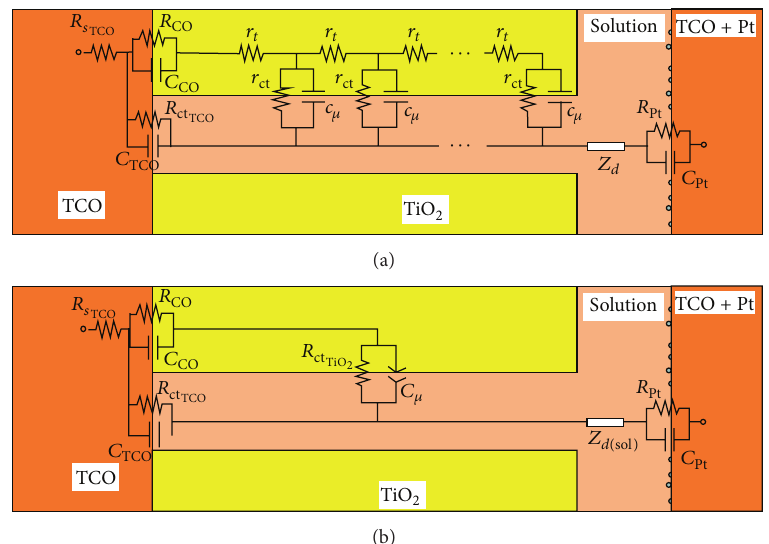
Figure 10: (a) General transmission line model and (b) simplified model at high illumination intensities of DSSCs. Reprinted (adapted) with permission from [7]. Copyright (2014) American Chemical